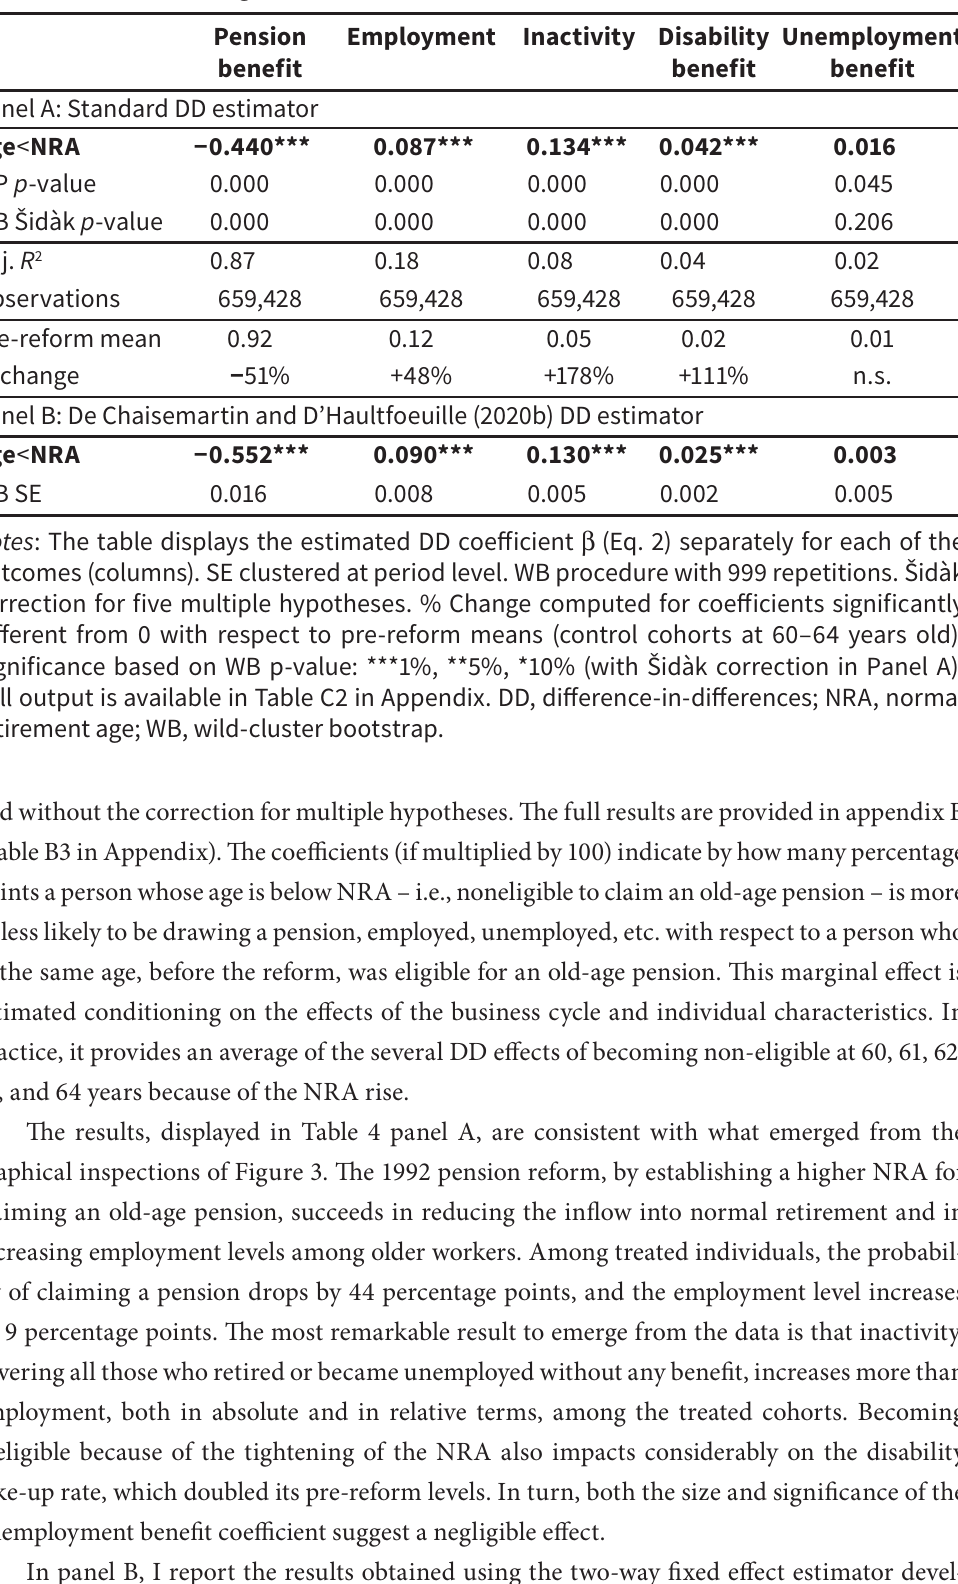
Effect of raising the NRA on different labor market outcomes Pension Employment Inactivity Disability benefit